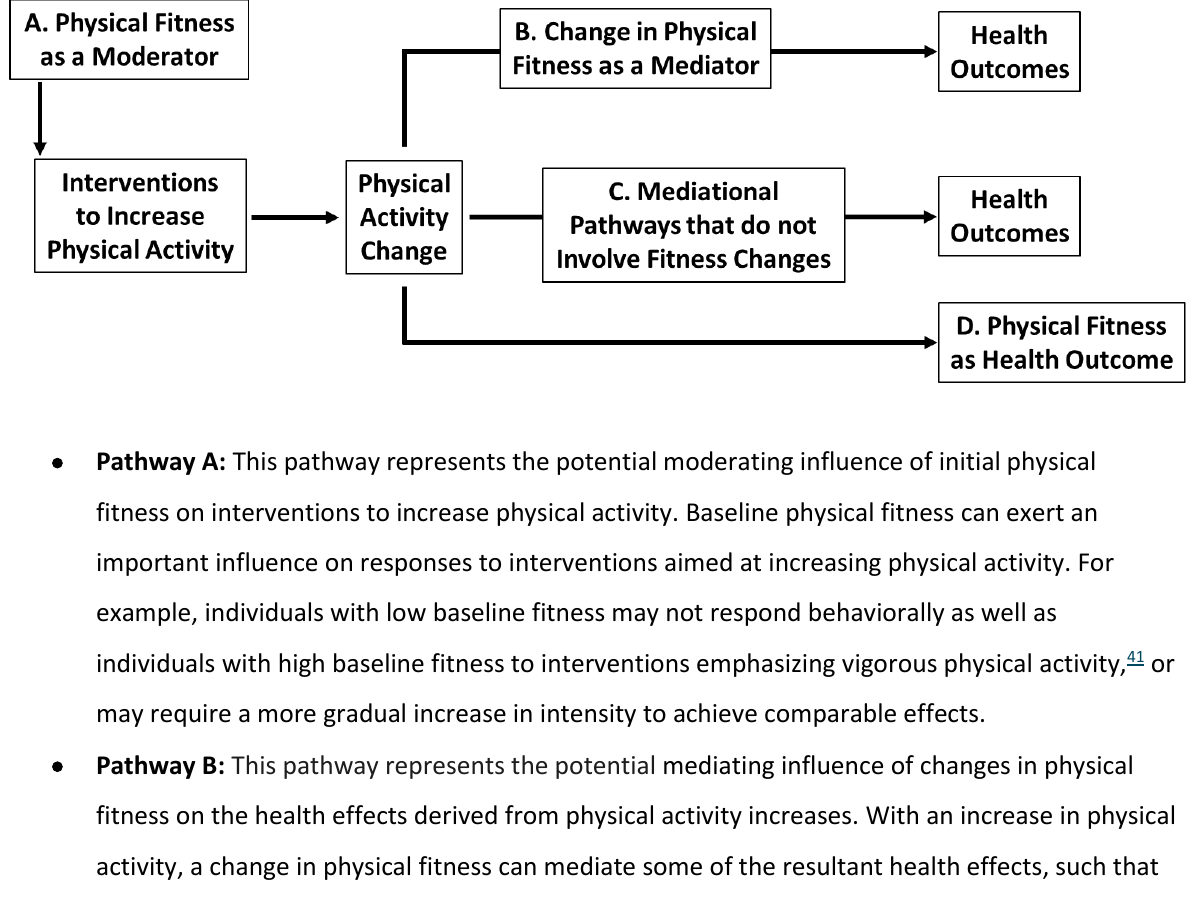
Figure C-9. The Role of Physical Fitness along Various Pathways between Physical Activity and Health Outcomes, Intervention